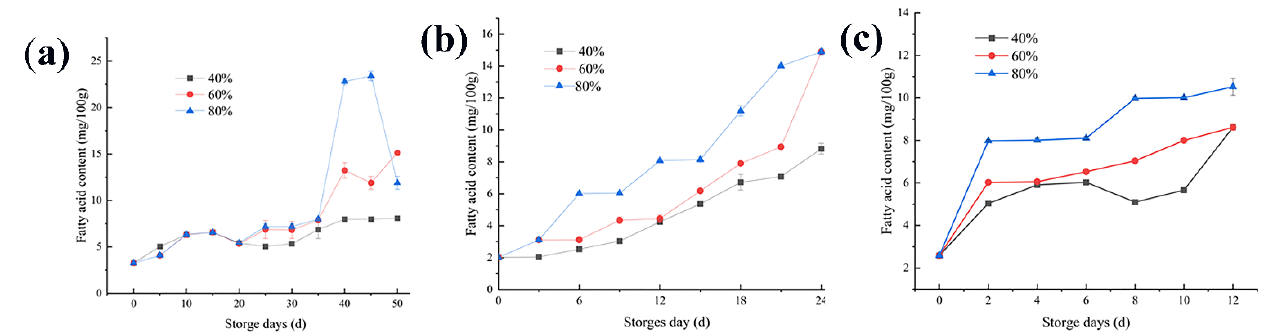
Figure 2. Changes in the rice fatty acid content at different storage temperatures: ( a ) 20 °C, ( b ) 30 °C, and ( c ) 35 °C .